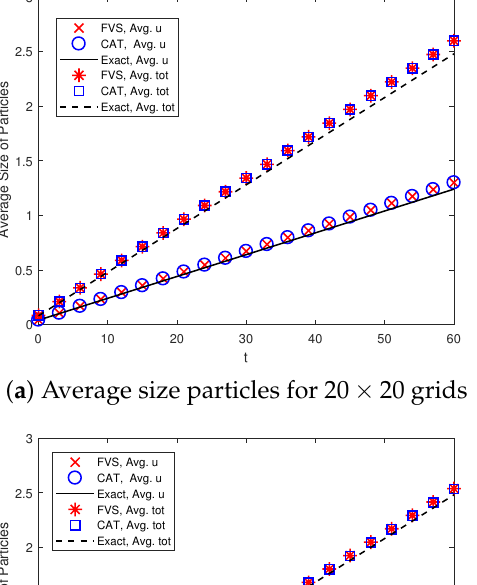
( b ) χ 2 parameter for 20 × 20 grids